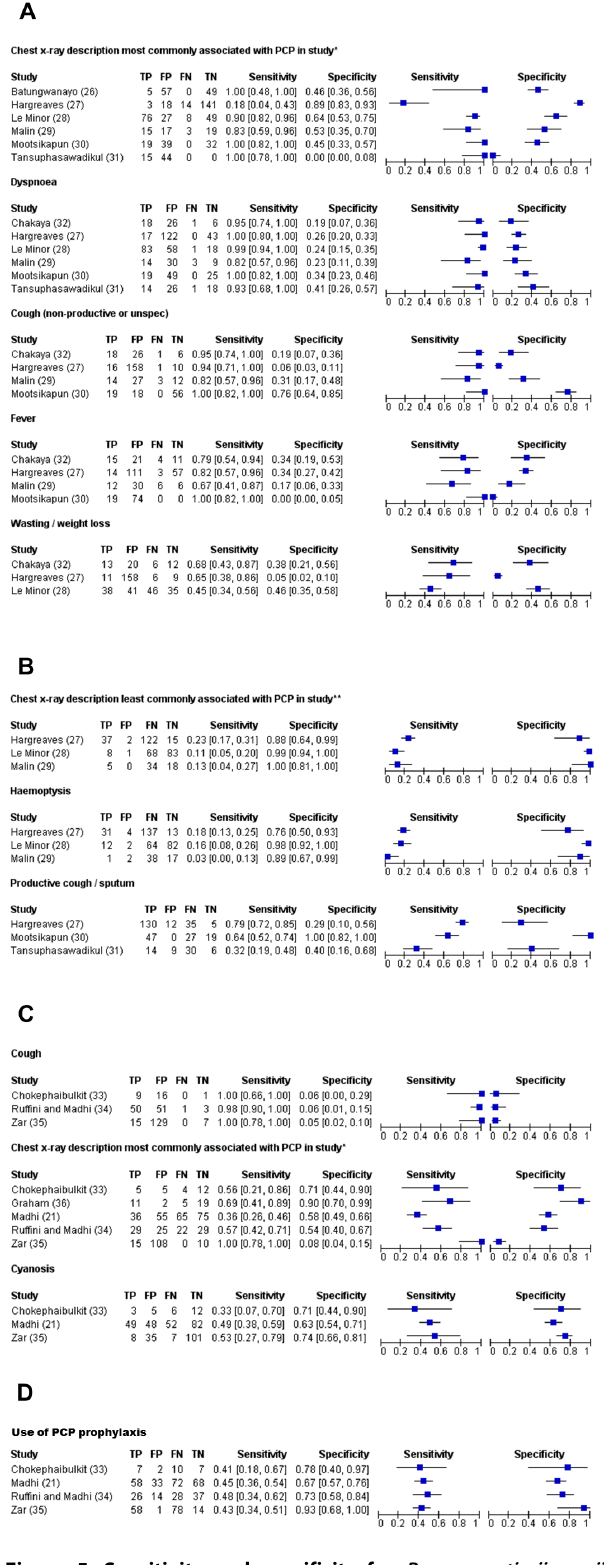
Figure 5. Sensitivity and specificity for Pneumocystis jirovecii pneumonia (PCP) of most commonly described signs, symp- toms, clinical tests or aspects of history. A. predictive of PCP in adults, B. predictive of absence of PCP in adults, C. predictive of PCP in children, D. predictive of absence of PCP in children. * Chest x-ray